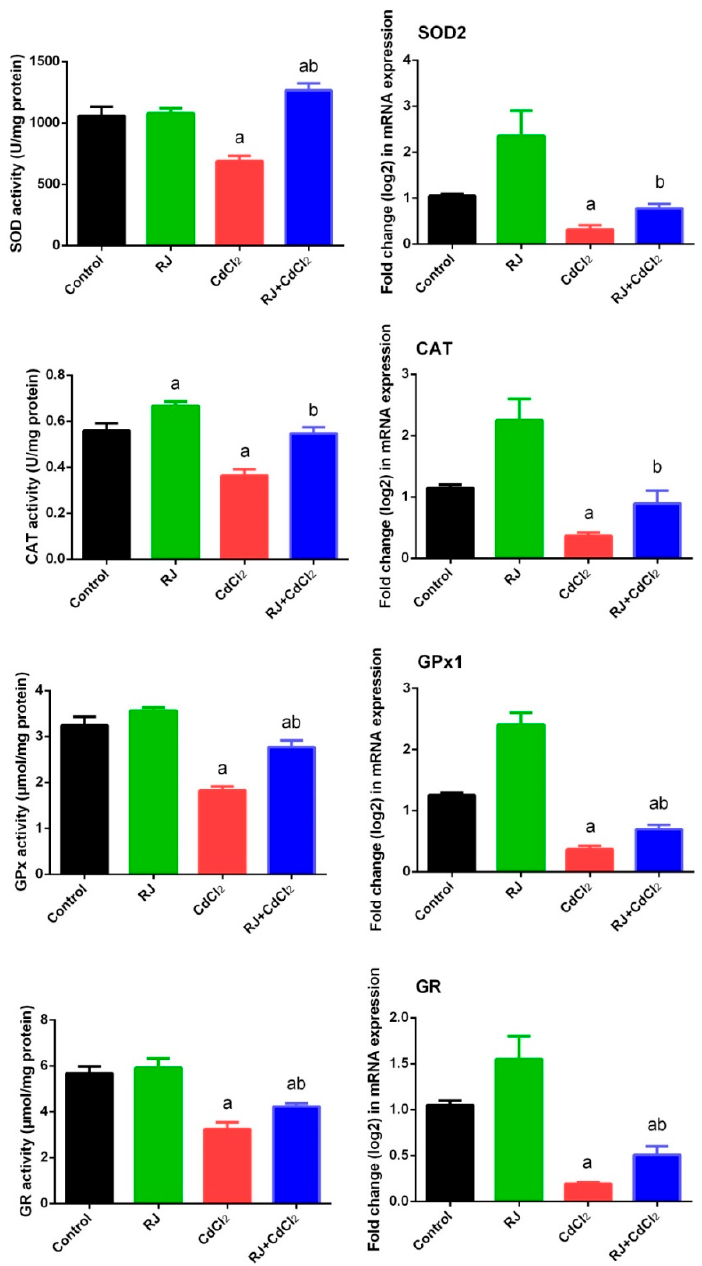
Figure 5. Effects of royal jelly (RJ) on the levels of superoxide dismutase (SOD), catalase (CAT), glutathione peroxidase (GPx), glutathione reductase (GR), and their corresponding mRNA expression in testes of mice exposed to cadmium chloride (CdCl 2 ). Values of antioxidant enzyme activities are expressed as the mean ± SEM (n = 7), whereas data on mRNA expression levels (mean ± SEM of triplicate assays) were normalized to the GAPDH mRNA levels and are shown as the fold induction (in log2 scale) relative to the mRNA levels in the controls. a refers to a significant change from the control mice at p < 0.05; b refers to a significant change from the CdCl 2 -treated mice at p < 0.05, using Duncan’s post hoc test.